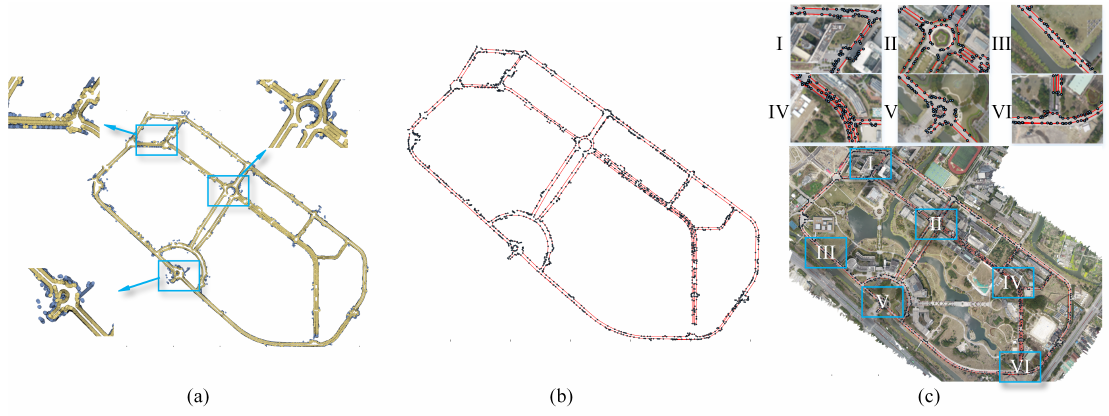
Figure 15. Experimental results of the proposed method on the Tongji campus. ( a ) resulting road boundary points (blue) and innermost road boundary points (yellow). ( b ) resulting vectorized map obtained by the proposed method. ( c ) the superposition of the vectorized map obtained by the proposed method and the aerial image of the mapped